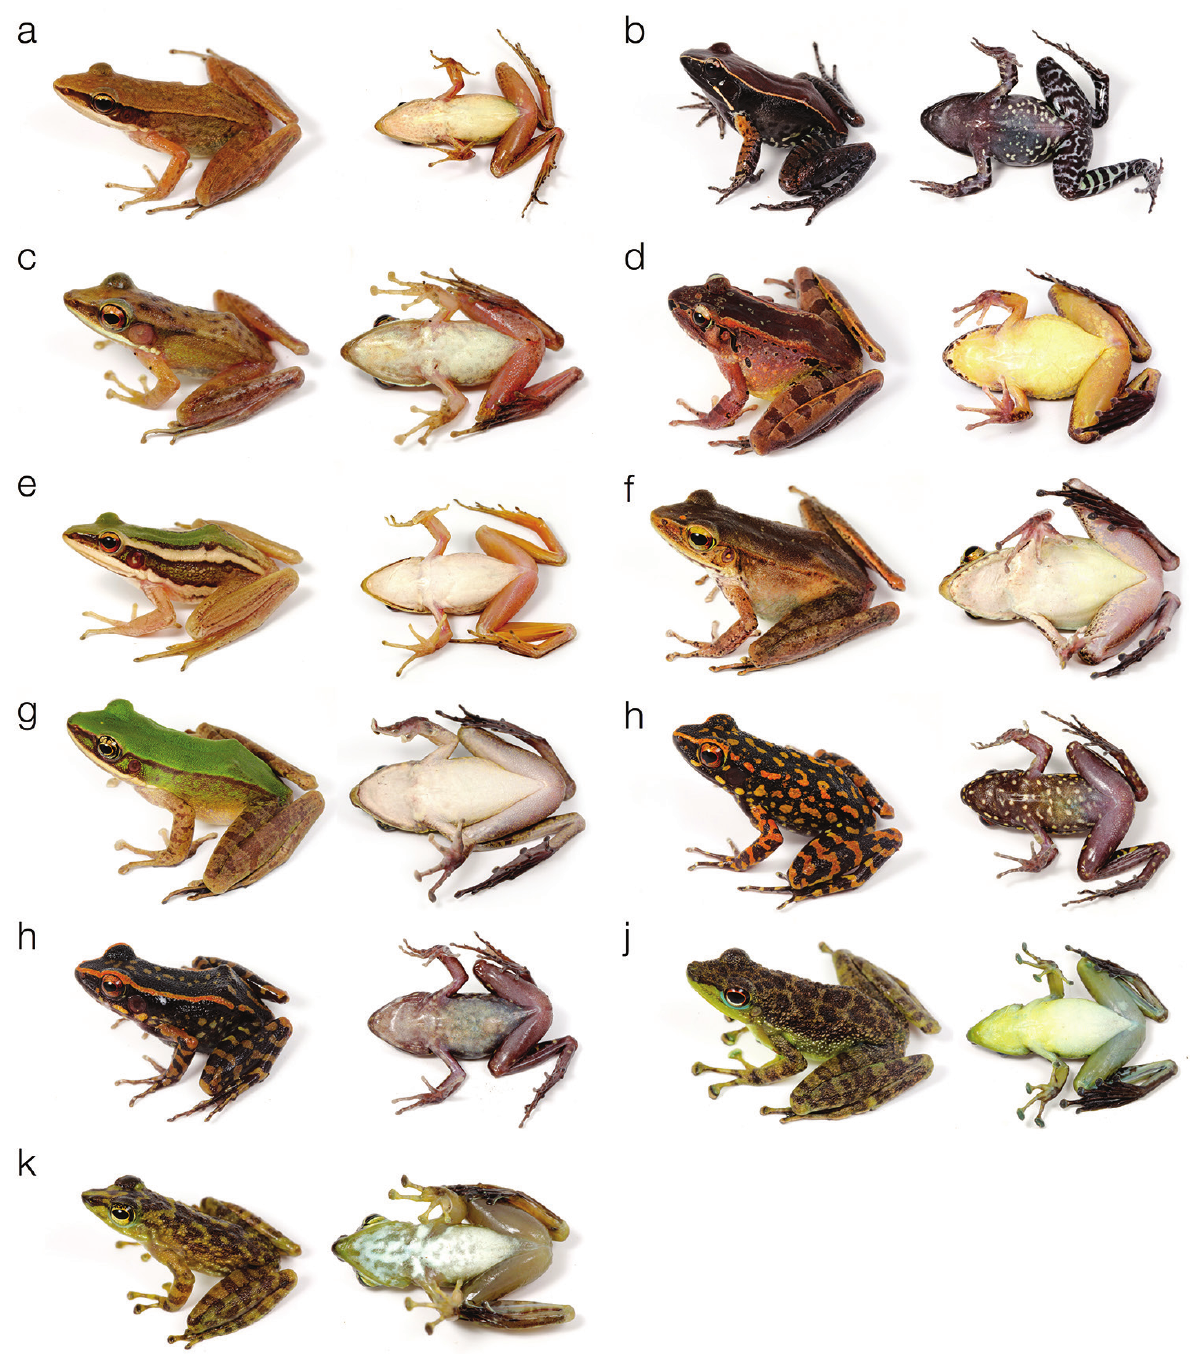
Figure 4. Frogs of the Ranidae at MBCA: a , Amnirana nicobariensis ; b , Abavorana luctuosa ; c , Chalcorana megalonesa ; d , Huia cavitympanum ; e , Hylarana erythraea ; f , Meristogenys orphnocnemis ; g , Odorrana hosii ; h , Pulchrana picturata ; i , Pulchrana signata ; j , Staurois guttatus ; k , Staurois tuberilinguis . Pairs of photos (dorsolateral and ventral) depict the same individual. narrow; finger and toe tips only moderately expand - abdomen ventrally all white; thighs flesh to orange in ed to rounded discs; toes webbed to half; dorsal skin color tympanum conspicuous, large, dark in color; iris texture smooth to granular, areolate at the flanks; col - golden in upper part, darker below, with dark mid-hori- or predominantly green above; dorsolateral fold thick, zontal band.—At Maliau, the species is abundant at the continuous and cream in color, bordered in dark brown; Study Center Laguna and roadside ditches. H. erythraea upper lip cream without marking; upper lip streak con - and A. nicobariensis frequently occur together in many tinues posteriorly in a lower longitudinal stripe at lower Bornean rural water bodies, such as village ponds and flank; upper side of limbs sandy brown; throat, chest and paddy